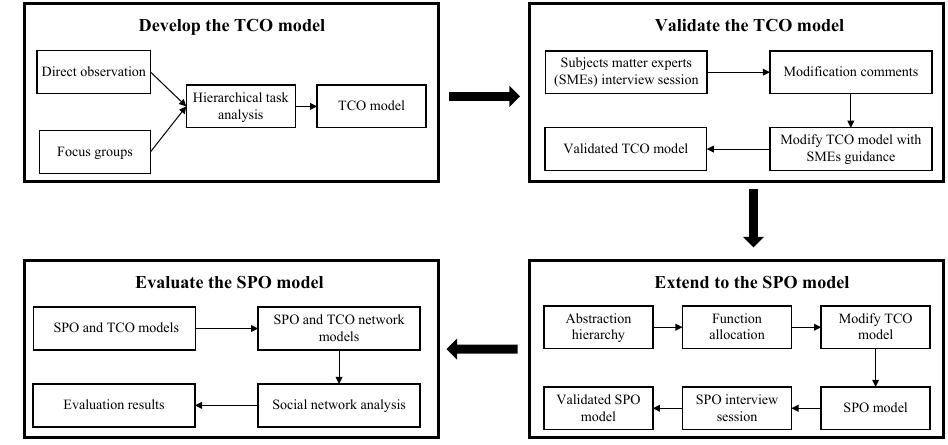
Figure 1. The logic flow chart of the single pilot operations